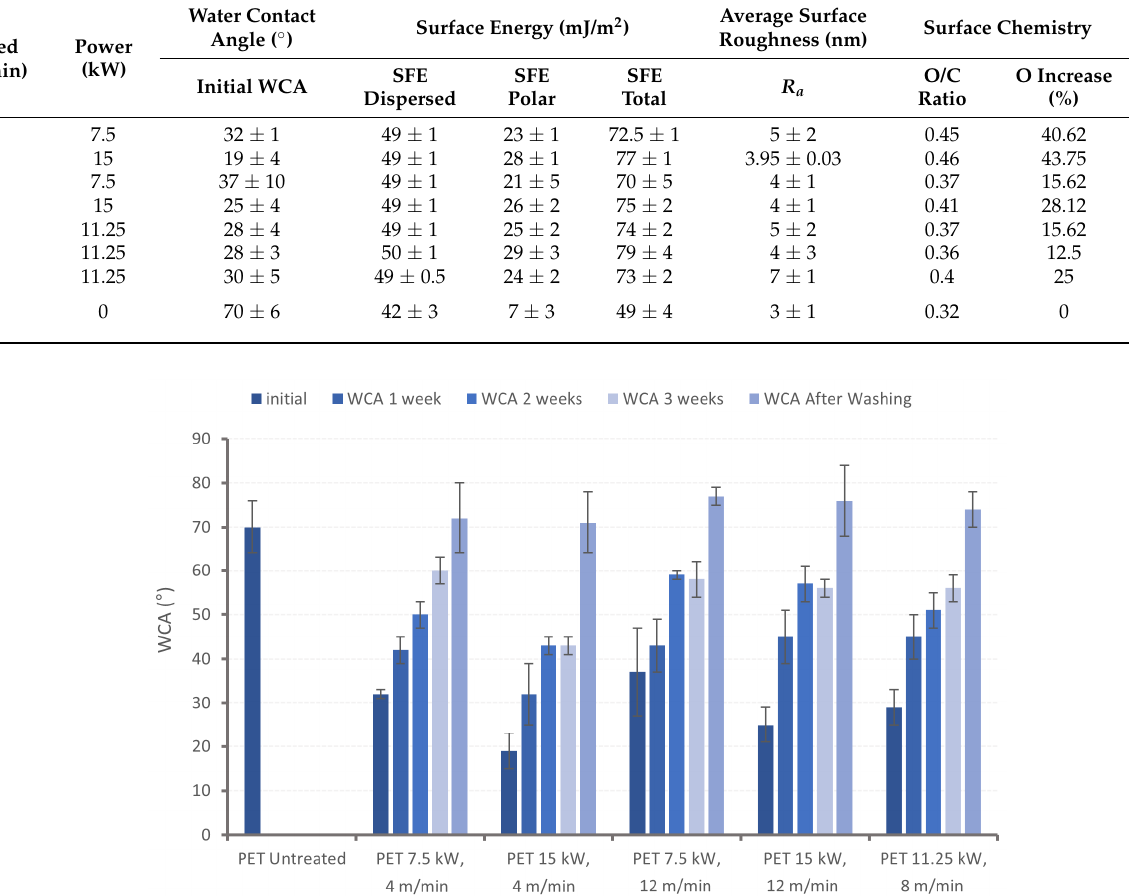
Table 2. Water contact angles, surface energy, average roughness and chemistry values found for the PET plasma-treated samples.